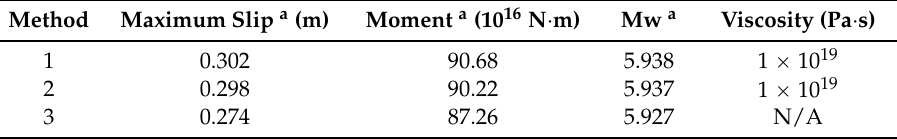
Table 3. Statistics of inversion results from different